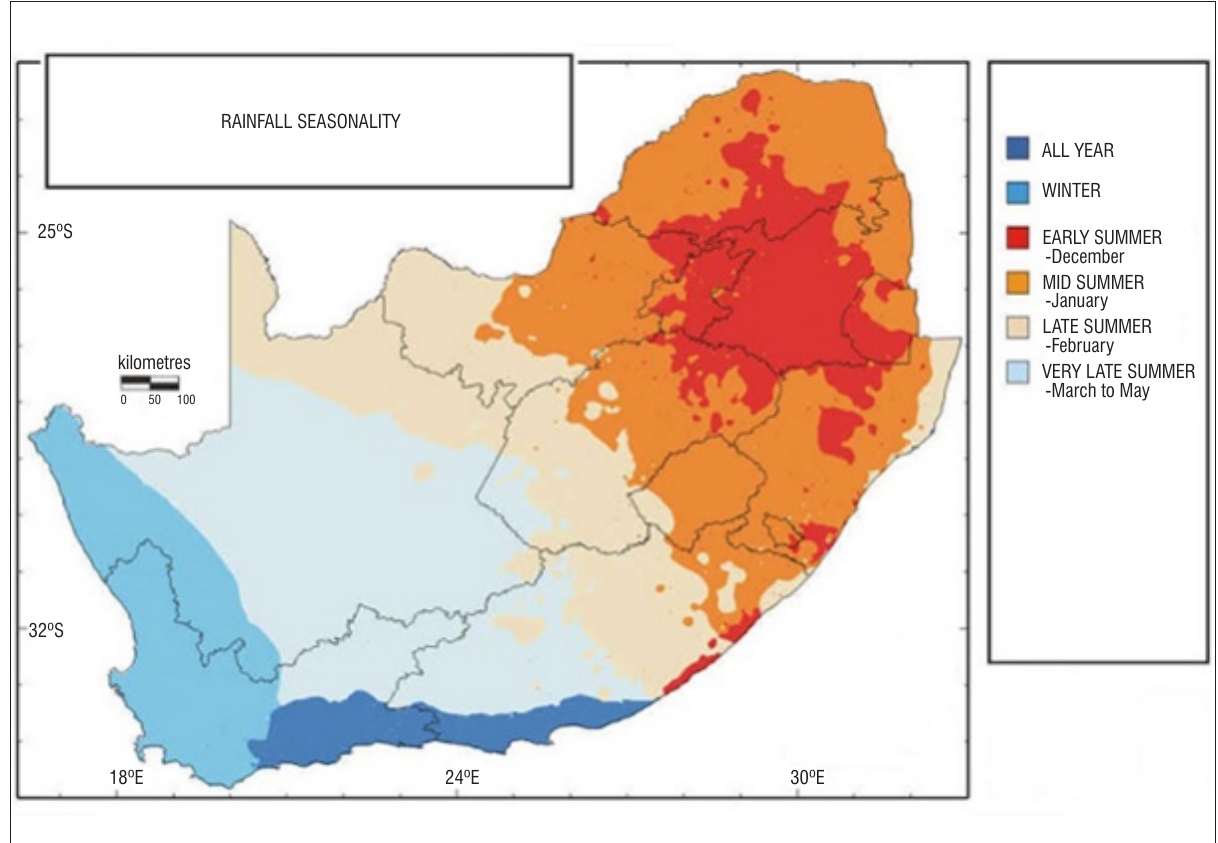
Figure 2 : Rainfall seasonality over South